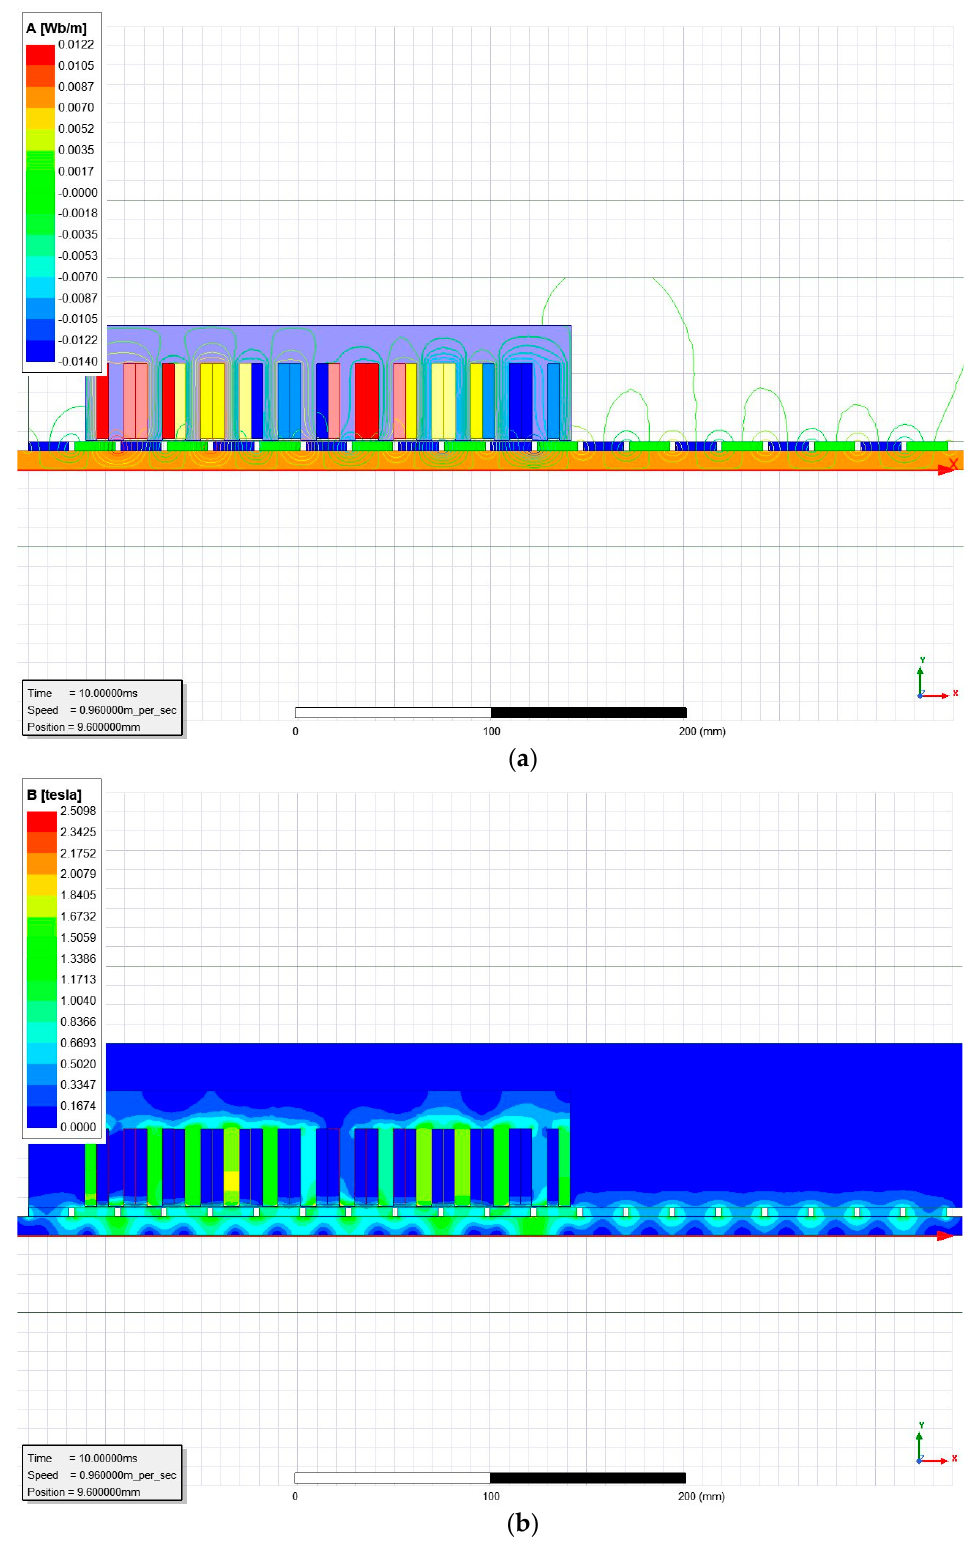
Figure 11. PMLSM magnetic field lines and magnetic flux density distribution cloud map ( a ) Magnetic field line distribution ( b ) Magnetic flux density distribution.